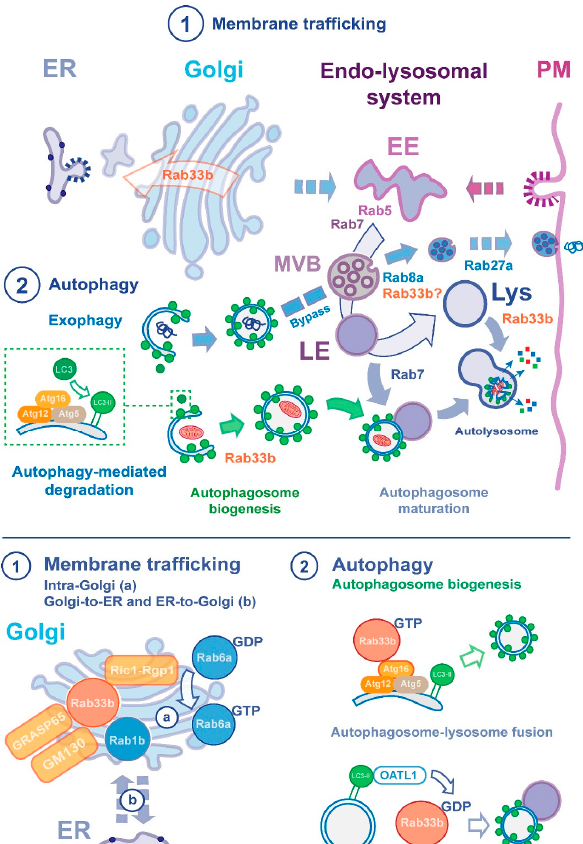
Figure 2. Rab33b at the intersection of membrane trafficking and autophagy. Key vesicle trafficking and autophagy pathways (upper panel). Compartmentalisation and establishment of stations along the endo-lysosomal system occur through a maturation process from early endosomes (EEs), multivesicular bodies (MVBs) and late endosomes (LEs) to mature lysosomes (Lys). A Rab cascade, that involves recruitment of Rab7 to Rab5 domains, leads to formation of a stable LE compartment before delivery to lysosomes. Autophagy-mediated degradation converges with this pathway. Biogenesis of autophagosomes at dedicated foci, culminates with recruitment of lipidated LC3 (green boxed inset) to pre-autophagosomal membranes. Next, autophagosome maturation results from the transport of autophagosomes towards EEs and LEs, and fusogenic events at distinct stages of the endosomal maturation pathway. Rabs participating in endocytic transport (i.e., Rab7) sustain the autophagic flux. Degradation of cytosolic components engulfed by autophagosomes occurs by fusion of autophagosomes or amphisomes that result from the fusion between autophagosomes and LEs with lysosomes. The resulting autolysosomes mediate the breakdown of autophagic cargo. A secondary arm of the autophagic pathway, also known as exophagy, plays a role in unconventional protein secretion. Rab proteins provide a regulatory role that avoids stages that result in autolysosomal formation for autophagosomes carrying unconventional secretory cargo. Autophagosomal secretion relies on fusion of autophagosomes with MVBs and subsequent fusion of these intermediates with the plasma membrane (PM). Blue arrows, biosynthetic transport; purple arrows, fusiogenic autolysosomal maturation steps. Rab33b, initially described to reside in the Golgi apparatus, contributes to multiple pathways through distinct e ff ectors. Specific roles in vesicular tra ffi cking and autophagy are indicated in the figure (lower panel, left and right side respectively). Rab33b localises to the medial Golgi cisternae and works alongside Rab6a and has an established role in (a) the structural organisation of the Golgi apparatus, and (b) retrograde Golgi-to-ER transport. Rab33b is the first Rab protein reported to interact with Atg16L for regulation of autophagosome formation. The function of a regulator of Rab33b, OATL, suggests a functional involvement of this GTPase in later stages of autophagy-mediated